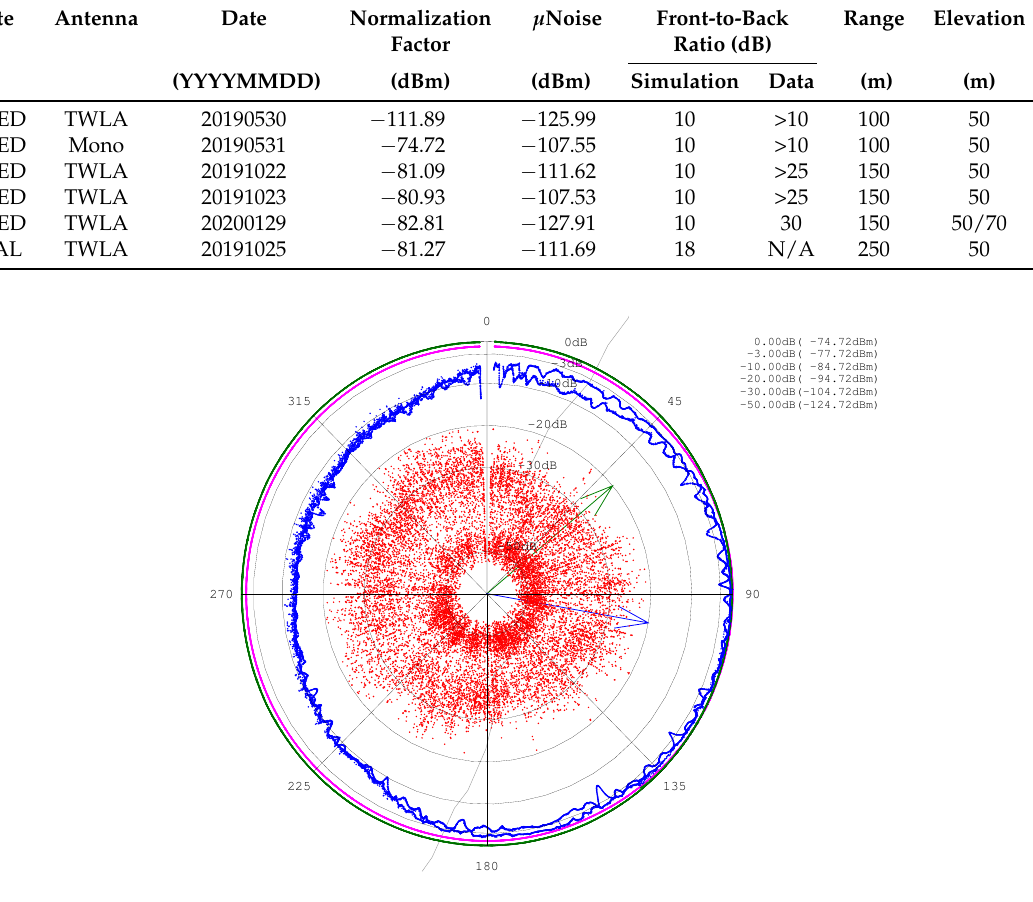
Figure 10. Results of the APM performed on the standard 5 MHz Seasonde transmitting antenna at our Red Head site on 31 May 2019 for both clockwise and anti-clockwise drone passes. Blue and red points correspond to normalized signal and corresponding noise levels respectively. Green and Magenta points represent the NEC2 model near and far field data respectively, projected onto the flightpath and normalized to their maxima. The blue arrow identifies the direction of the expected maximum. The green arrow is the direction to the partner SeaSonde